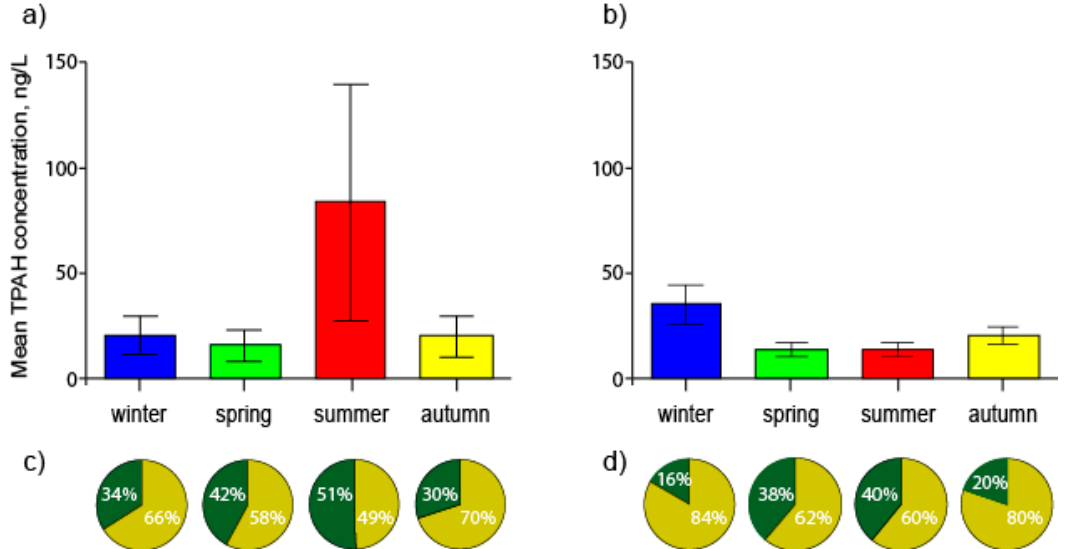
Figure 2. The seasonal variations of TPAHs in the estuarine waters of the Tumen River Estuary ( a ) and the Partizanskaya River Estuary ( b ) and relative contribution (%) of dissolved and particulate PAHs in the Tumen River Estuary ( c ) and the Partizanskaya River Estuary ( d ). Error bars represent one standard deviation from the mean value. The Tumen River Estuary: n = 10 in winter and summer, n = 12 in spring and autumn. The Partizanskaya River Estuary: n = 8 in winter, n = 16 in every other season.